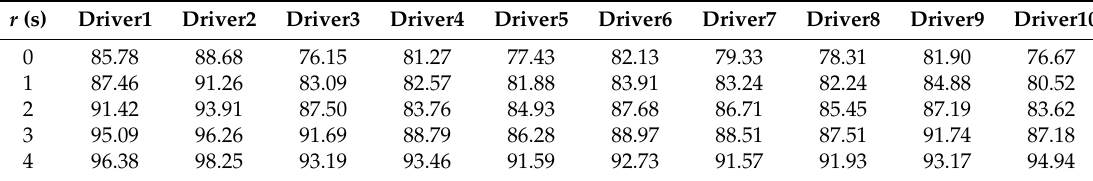
Table 7. Classification accuracy (%) of the testing data (O2).